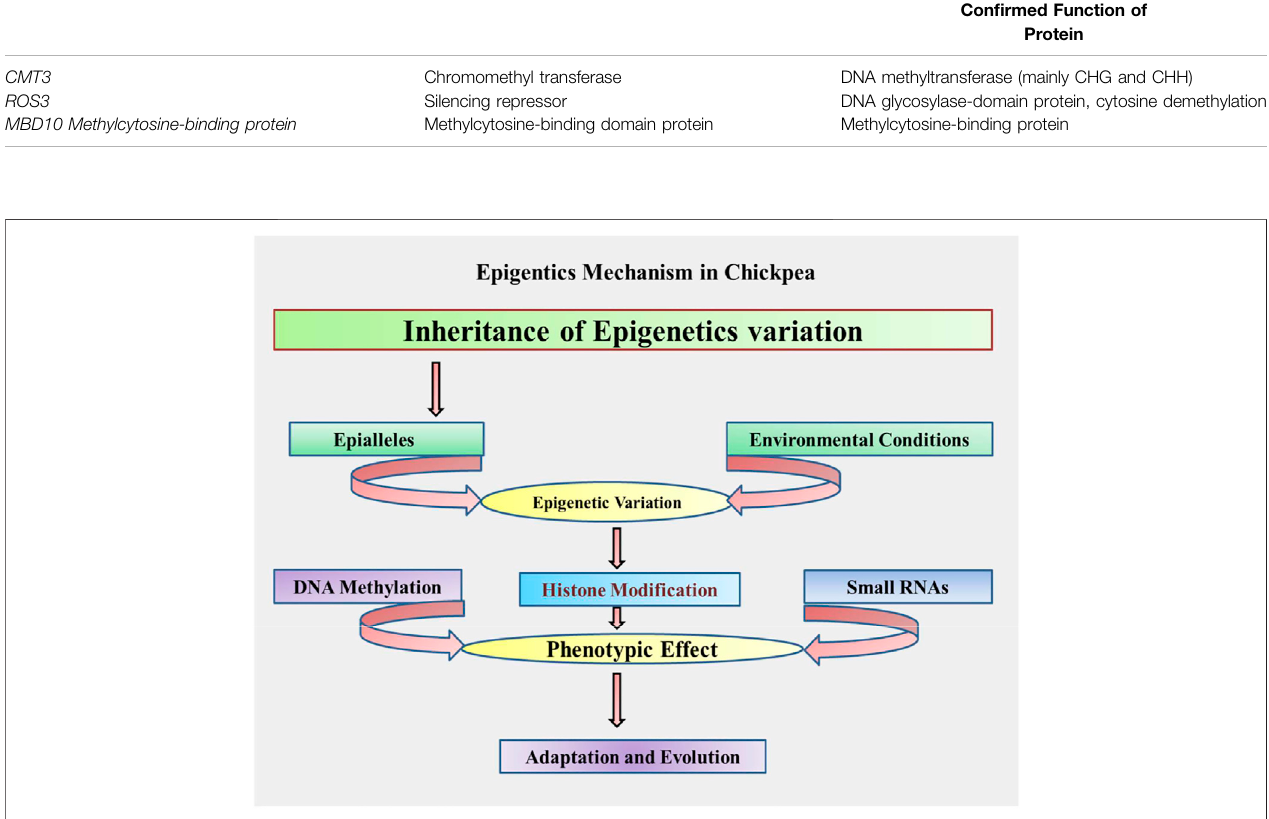
FIGURE 2 | Proposed schematic mechanism/process of epigenetics in